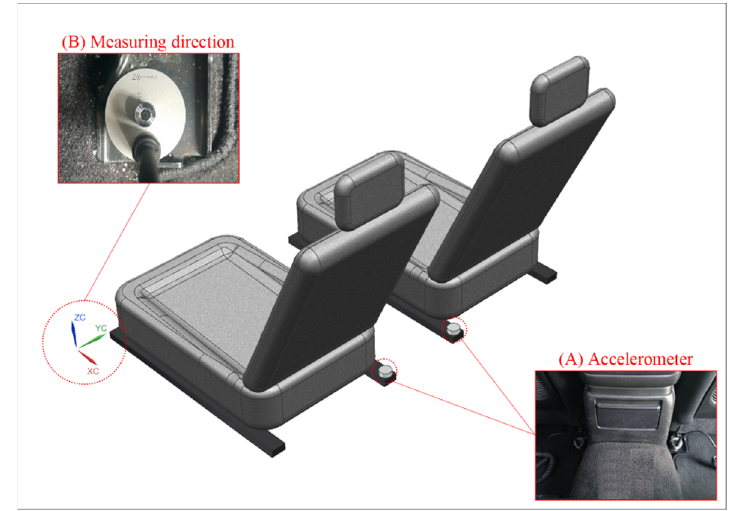
Figure 4. Accelerometer installed to measure the vibration. ( A ) Accelerometer installed on a seat frame; ( B ) measurement direction of the accelerometer.